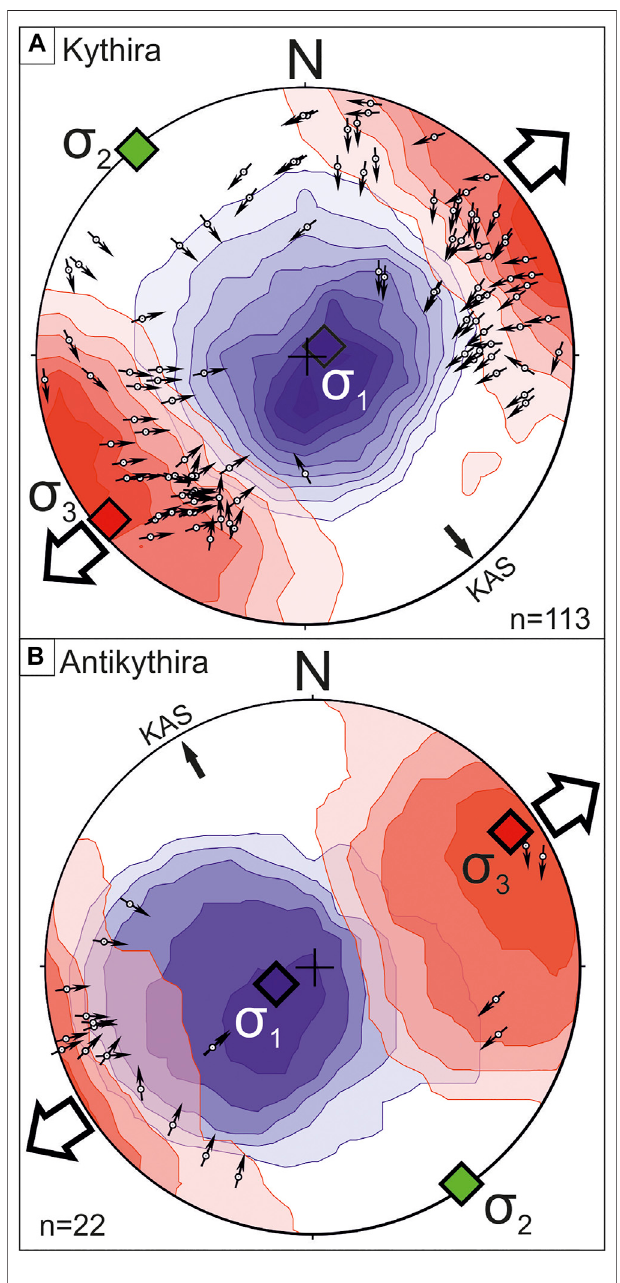
FIGURE 8 | Plot showing the extension direction derived from striations collected on exhumed postglacial fault scarps in Kythira (A) and Antikythira (B) . The main stresses are plotted with red ( σ 3), green ( σ 2) and blue ( σ 1) diamonds. Red and blue shading represent P-T axes density contours. WhitearrowsindicatetheaverageextensiondirectionwithintheKASwhilethe average strike of the KAS is indicated by black arrow.